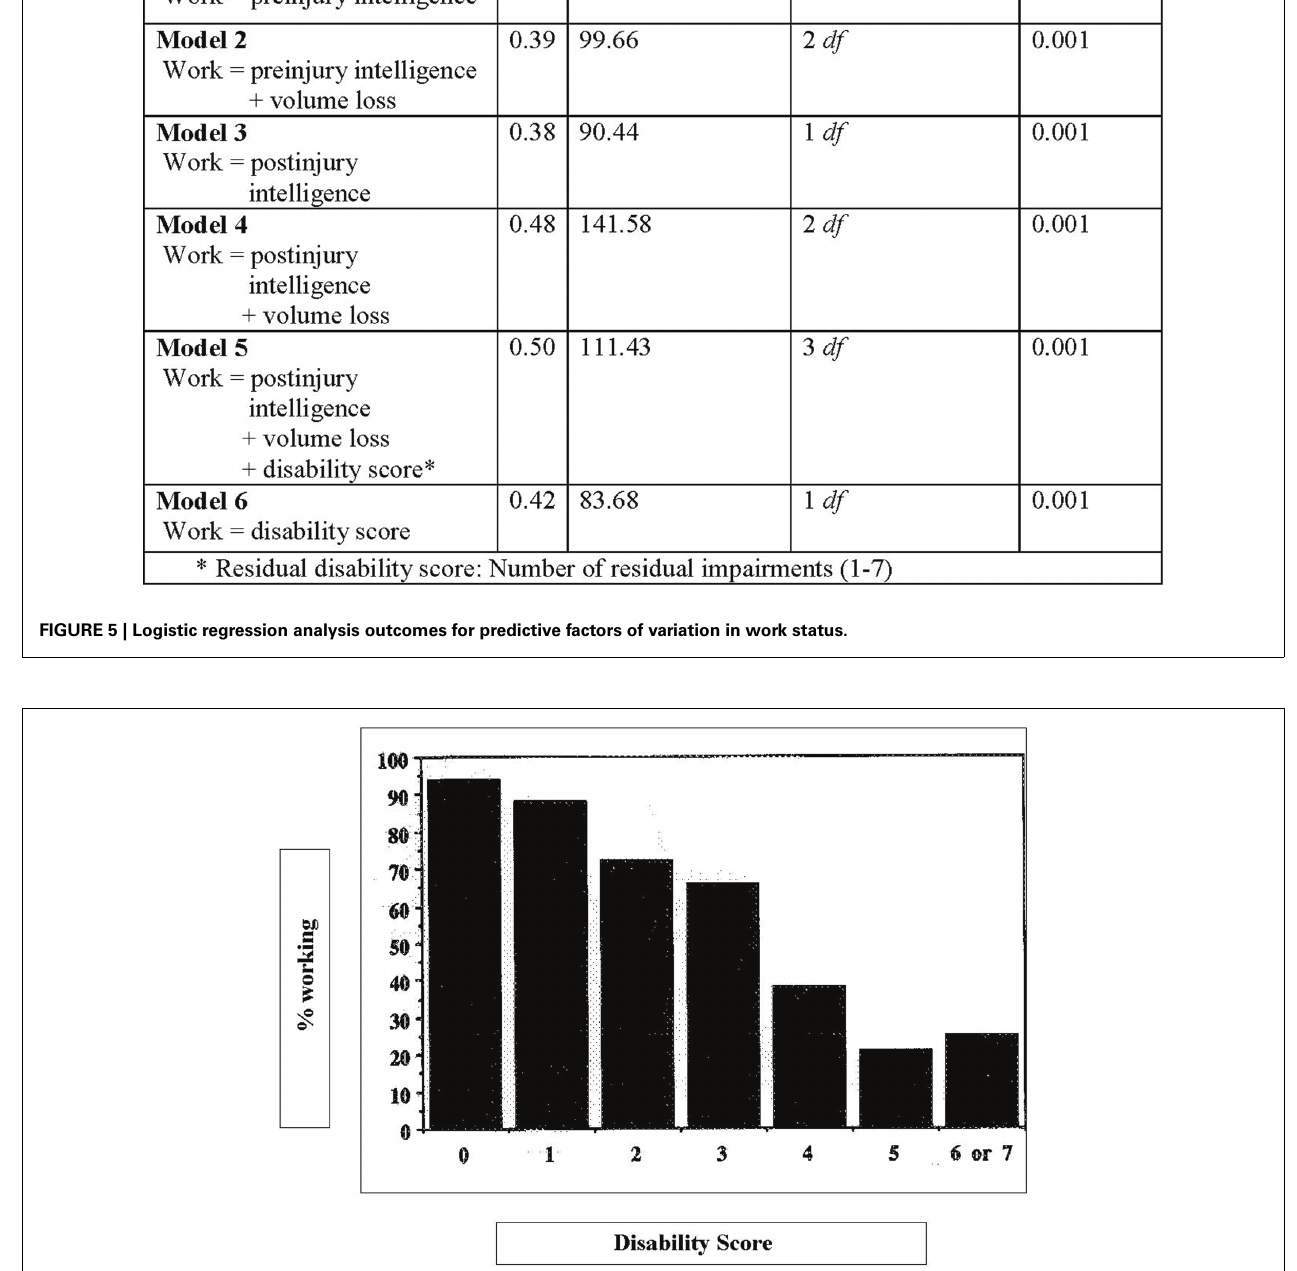
FIGURE 6 |Vietnam Head Injury Study, percent working by disability score. The disability score represents the number of disabilities present (1–7).